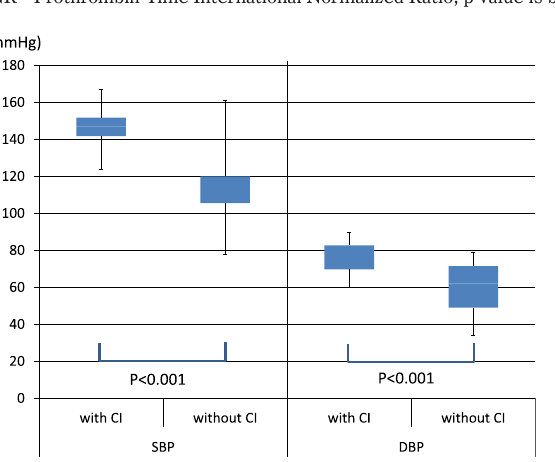
Figure 2 Comparison of the blood pressures of the cerebral infarction group and the non-infarction group. Both the systolic and diastolic blood pressures were significantly increased in the cerebral infarction group. SBP=Systolic blood pressure, DBP=Diastolic blood pressure, CI=Cerebral infarction.